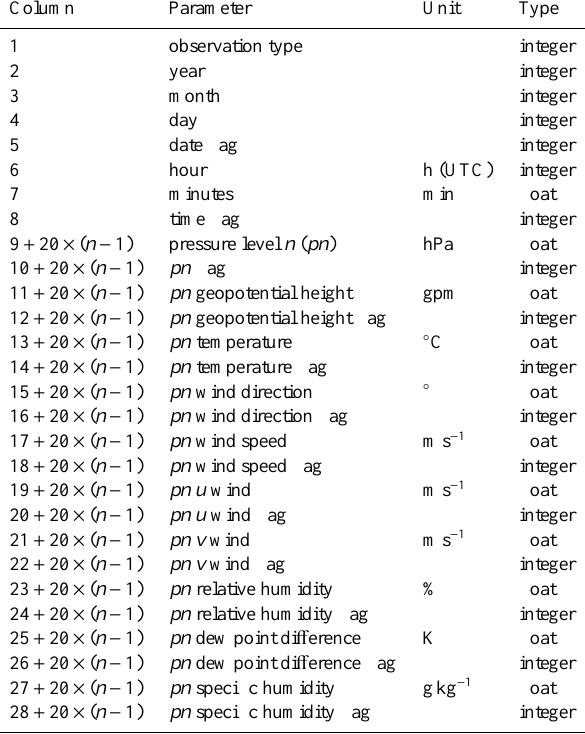
Table 7. Definition of the columns in the fixed station upper-air ge- ometrical height level format ASCII files used for the ERA-CLIM data. Su ffi ces .1 / .2 added to flag values signify observation values obtained during ascent / descent of a kite or captive balloon (see Ta- ble 7). n runs from 0 to 100.